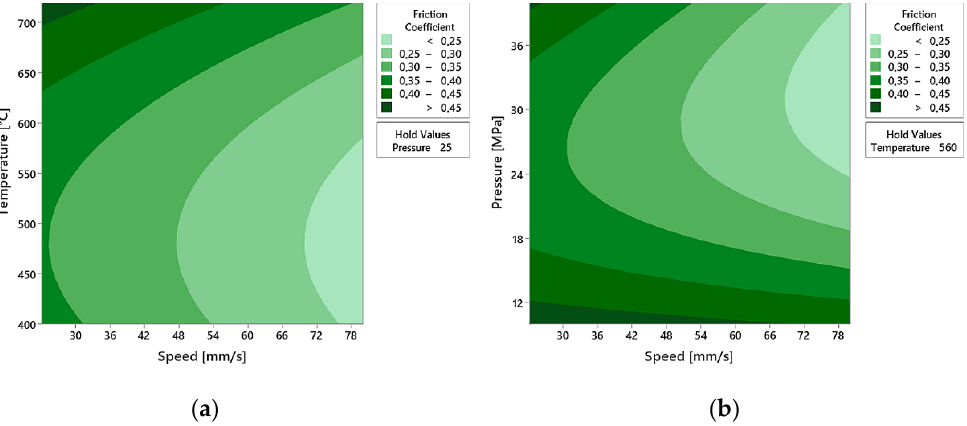
Figure 3. Contour Plot of: ( a ) Friction Coefficient vs. Temperature and Speed for a Hold Value of Pressure of 25 MPa; ( b ) Friction Coefficient vs. Pressure and Speed for a Hold Value of Temperature of 560 °C.